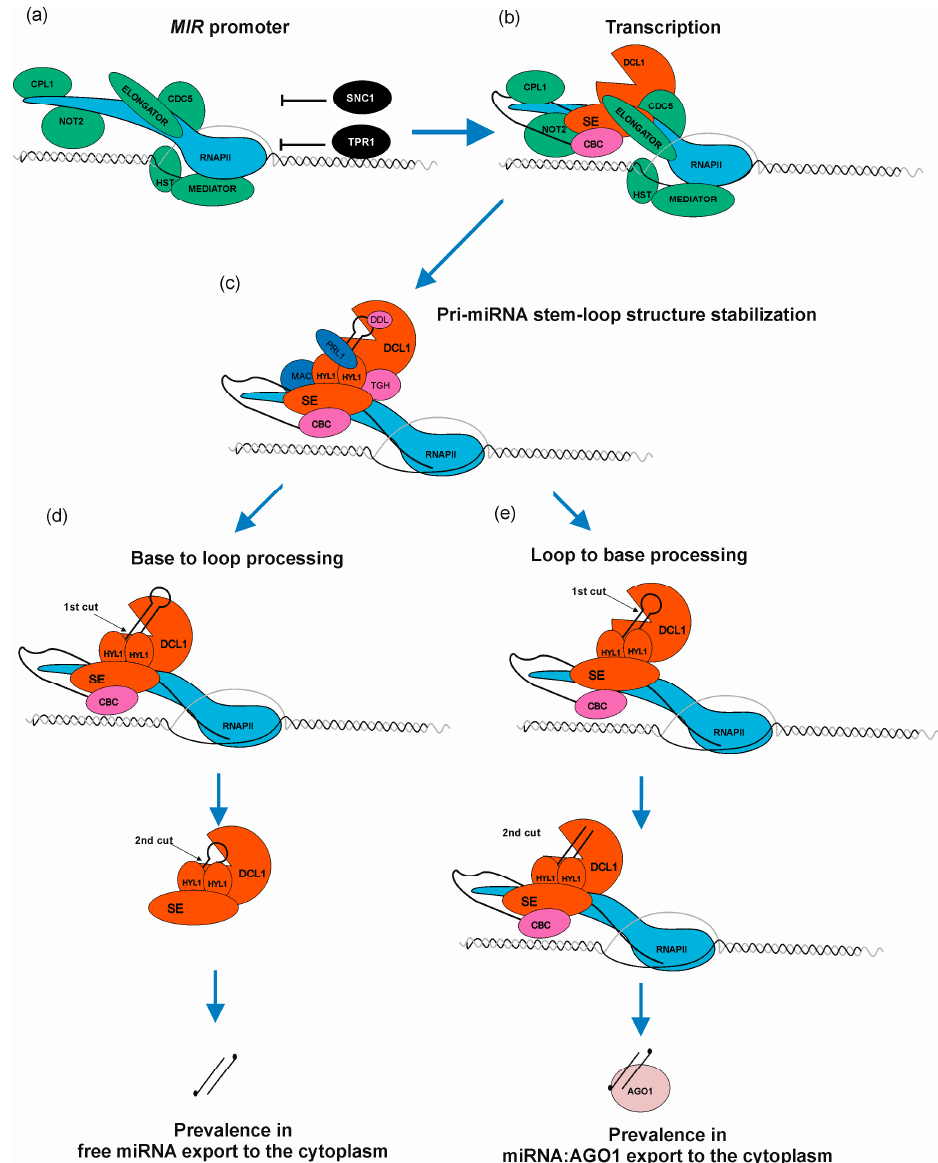
Figure 3. MicroRNA biogenesis is a complex process requiring a plethora of accessory proteins to regulate a proper level of mature miRNA. ( a ) RNAPII, ELONGATOR complex, MEDIATOR complex, C-TERMINAL DOMAIN PHOSPHATASE-LIKE1 protein (CPL1), NEGATIVE ON TATA LESS2 protein (NOT2), CELL DIVISION CYCLE5 (CDC5), HASTY (HST), SUPPRESSOR OF NPR1-1, CONSTITUTIVE1 (SNC1) as well as TOPLESS-RELATED PROTEIN1 (TPR1) bind to MIR loci. Green color marks positive regulators of miRNA transcription and black color marks negative